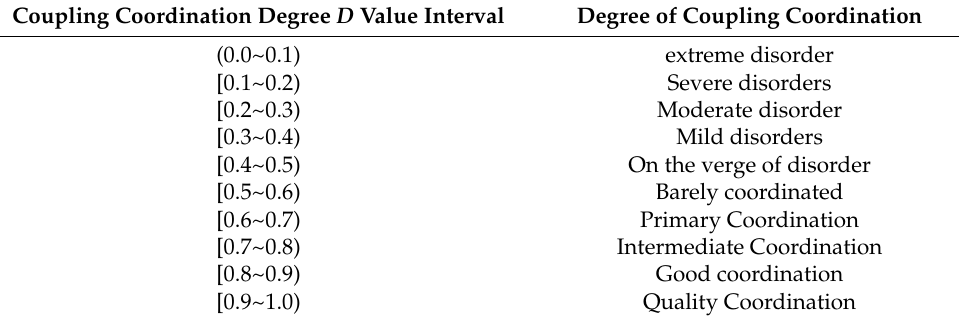
Table 1. Classification criteria of coupling coordination